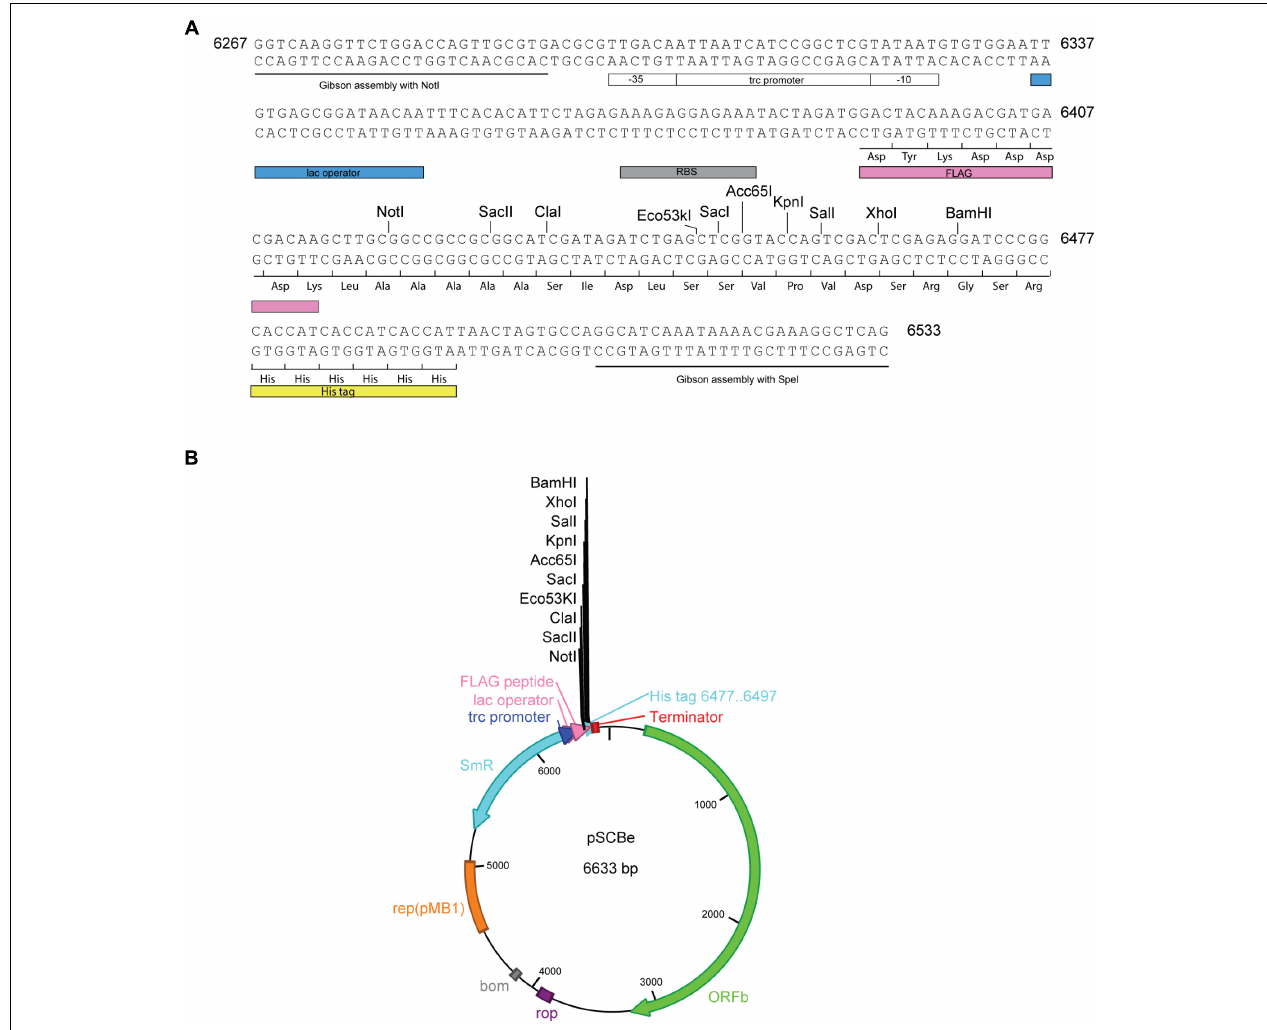
FIGURE 3 | pSCBe expression vector generation. (A) pSCBe-MCS fragment synthesized from IDT. The fragment contains two 26 bp upstream and downstream overlap sequences for Gibson assembly; Trc1O promoter which has lac operator; RBS site; an N-terminal FLAG tag; MCS with 10 unique enzyme digestion sites when clone into NotI and SpeI digested pSCB-YFP; and a C-terminal His tag. Number 6267 to 6533 indicated fragment position on pSCBe vector. (B) Expression vector pSCBe graph. The detail generation procedure and property of plasmid was described in “Materials and Methods” and “Results” sections.